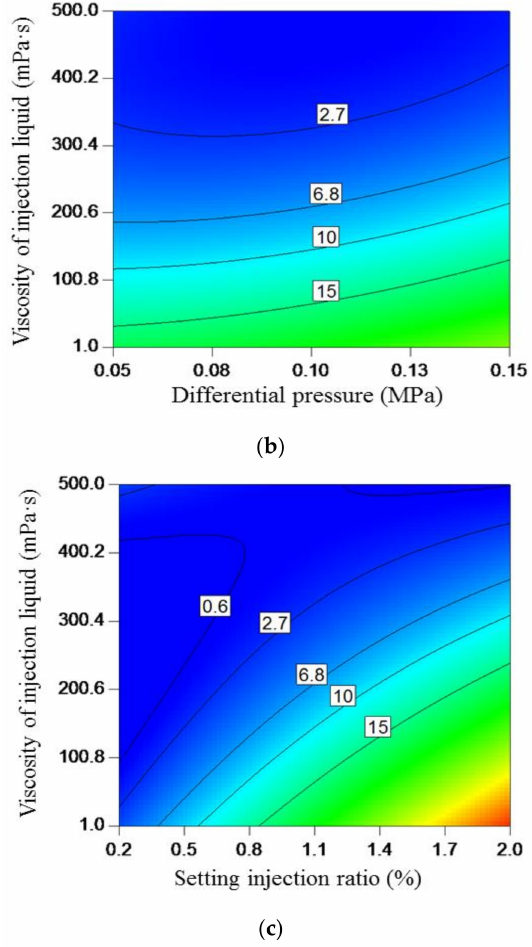
Figure 10. Contour of interaction influence between di ff erent factors and Q ij : ( a ) e ff ect of A and B ; ( b ) e ff ect of A and C , ( c ) e ff ect of B and C